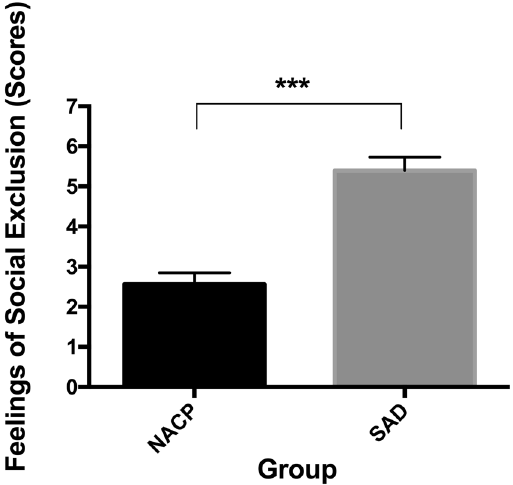
Figure 2. Self-report post-manipulation feelings of social exclusion scores for individuals qualifying for the diagnosis of social anxiety disorder (SAD) and matched nonanxious control participants (NACP). Error bars represent standard errors of the mean; *** p <